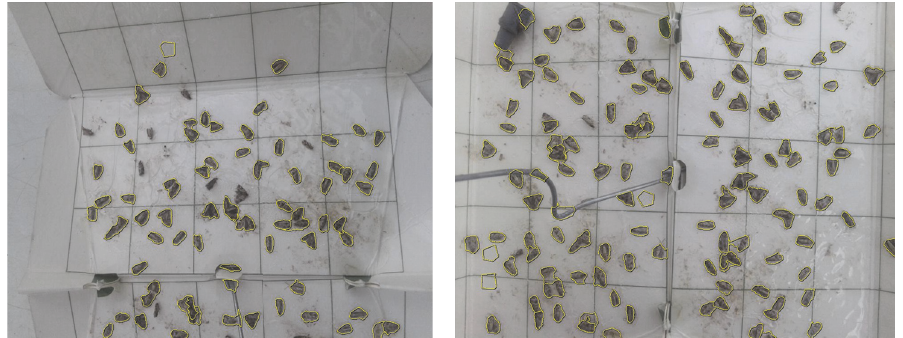
Figure 15: Example of processed images.